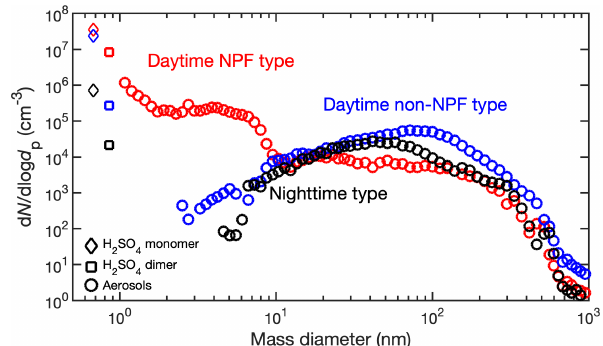
Figure 2. Cases of three typical types of number size distributions from H 2 SO 4 monomer to dimer and then to larger aerosol size: the daytime NPF type (red), daytime non-NPF type (blue), and night- time type (black). The daytime NPF, daytime non-NPF, and night- time particle number size distribution (PNSD) is selected during the NPF period on a NPF day (16 February 2018, 11:10LT), during the daytime on a non-NPF day (25 February 2018, 12:25) and during the nighttime (4 April 2018, 00:35). The diamonds, squares, and circles represent the distribution function (d N /dlog d p ) of H 2 SO 4 monomers, dimers, and aerosols, respectively.